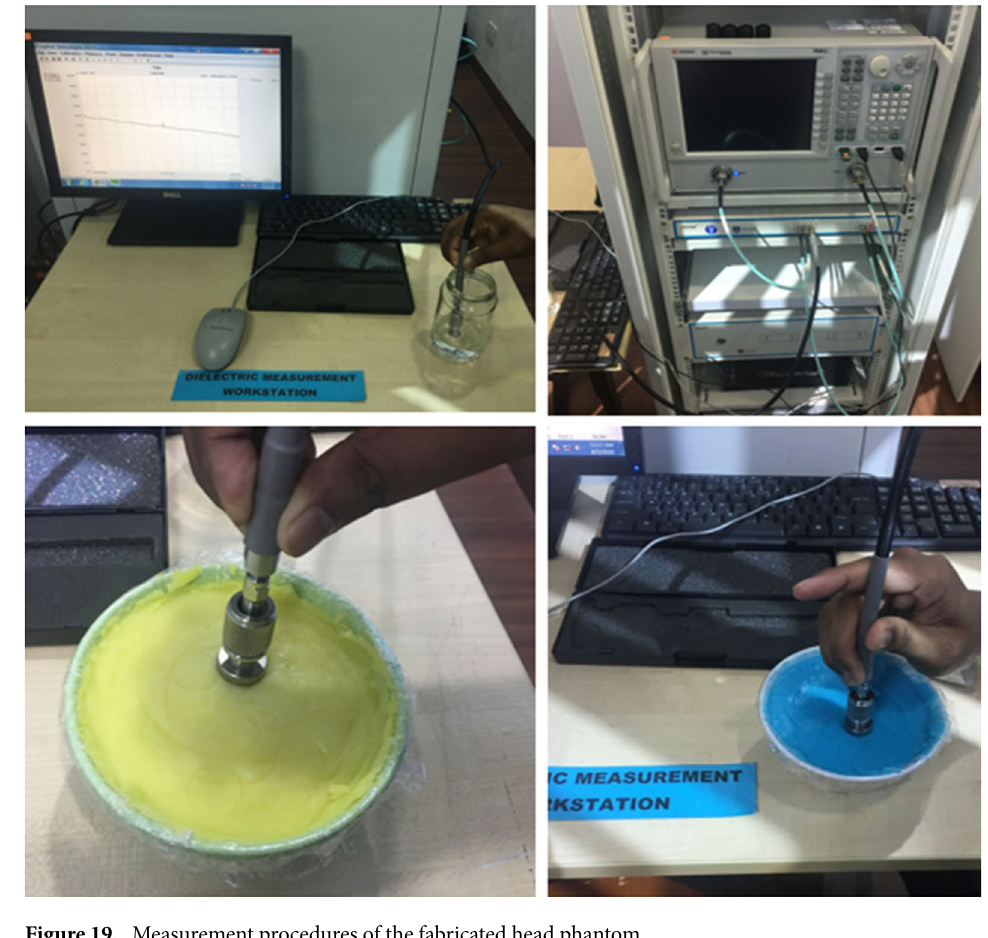
Figure 19. Measurement procedures of the fabricated head phantom.